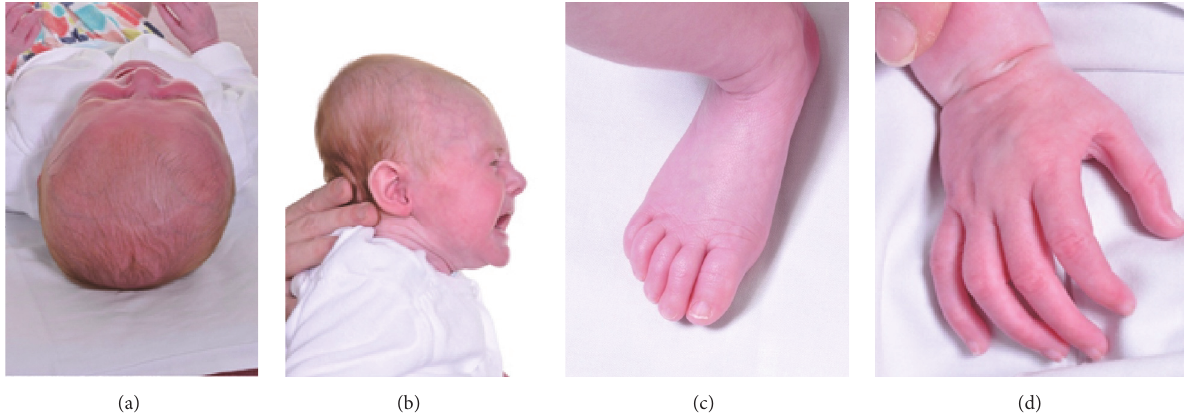
Figure 1: Photos of the proband taken at 6 weeks: (a) plagiocephaly with prominent coronal sutures. (b) Turricephaly. (c, d) Arachnodactyly. © Oxford Medical